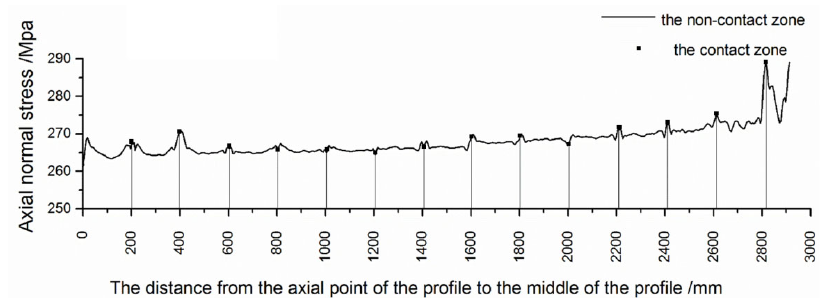
Figure 7. The calculation of axial normal stress, the profile measurement area and measurement paths.